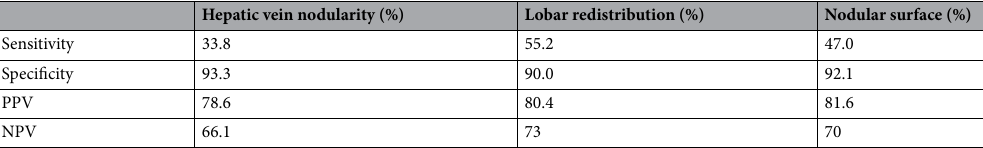
Table 3. Diagnostic performance of ultrasound parameters for cirrhosis (F4). NPV, negative predictive value; PPV, positive predictive value.